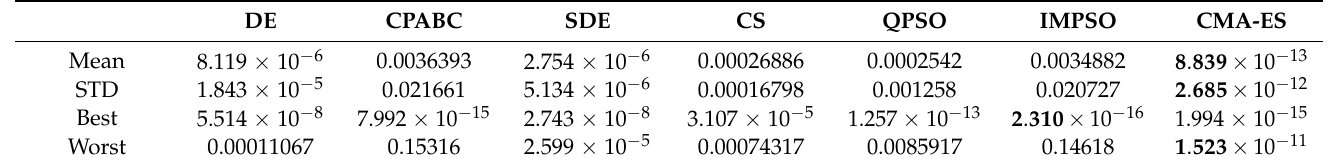
Table 6. Position error results for target point 3. The best results are highlighted in bold.